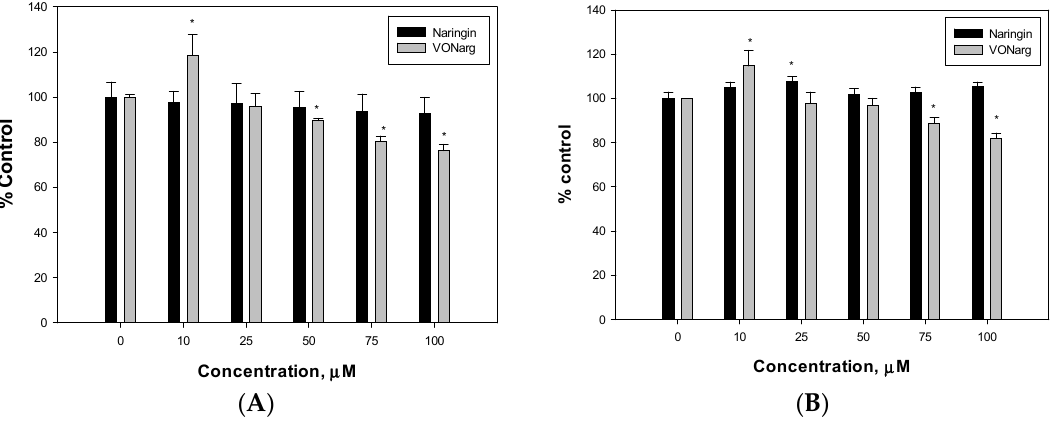
Figure 7. Effect of naringin and VONarg on GSH cellular levels ( A ) and GSH/GSSG ratio ( B ) in A549 cells. Results are expressed as mean ± SEM of three independent experiments, * significant differ- ences in comparison with the control level ( p < 0.05).